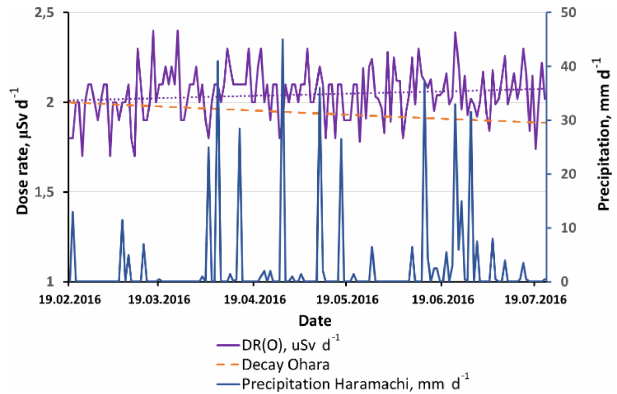
Figure 4. The time dependence of the D-shuttle readings (µSvd − 1 ) recorded from spot on the soil surface 20cm below the dosimeter for the site, located on the floodplain of Niida river (N2) and data on daily precipitation (mmd − 1 ) for Haramachi meteorological station of Japan Meteorological Agency for the similar time